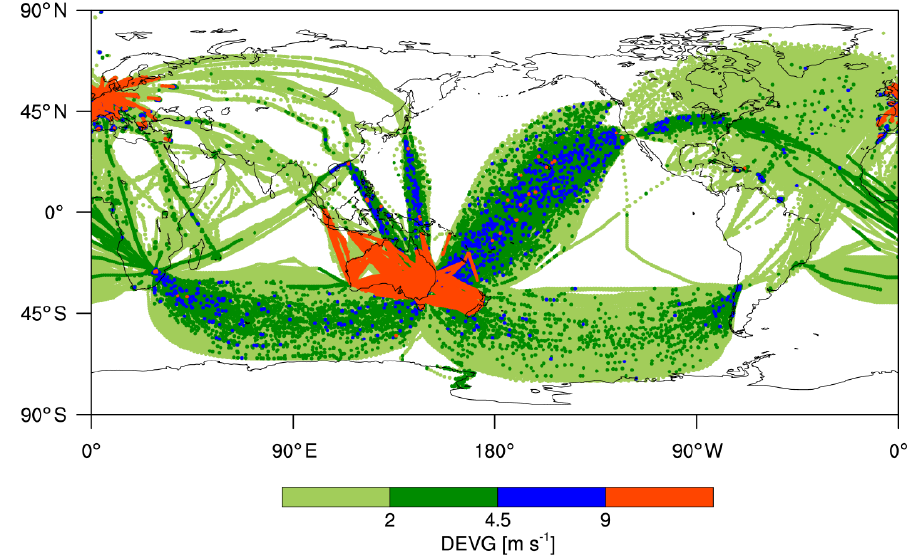
Figure 2. Horizontal locations of turbulence encounters expressed in raw DEVG values at altitudes above 15kft ( ∼ 4 . 57km) from October 2015 to September